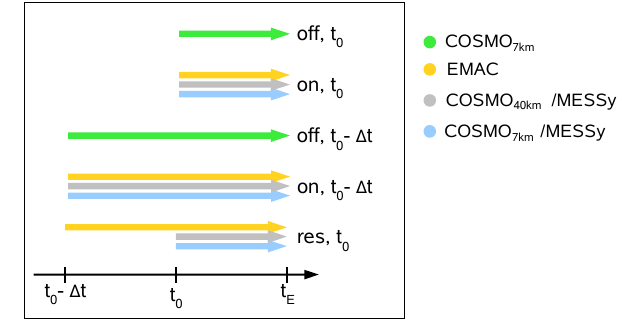
Fig. 3. Illustration of the different start times t 0 and t 0 − ∆ t of the on- and off-line simulations, compared in Sect. 5 and 6. The colours used for the different models correspond to Fig. 1. the respective off-line simulations with corresponding start times. Additionally, for the first and second case study, “restart simulations” are performed, where EMAC simula- tions are started at time t 0 − ∆ t , prior to the COSMO simu- same time t E .